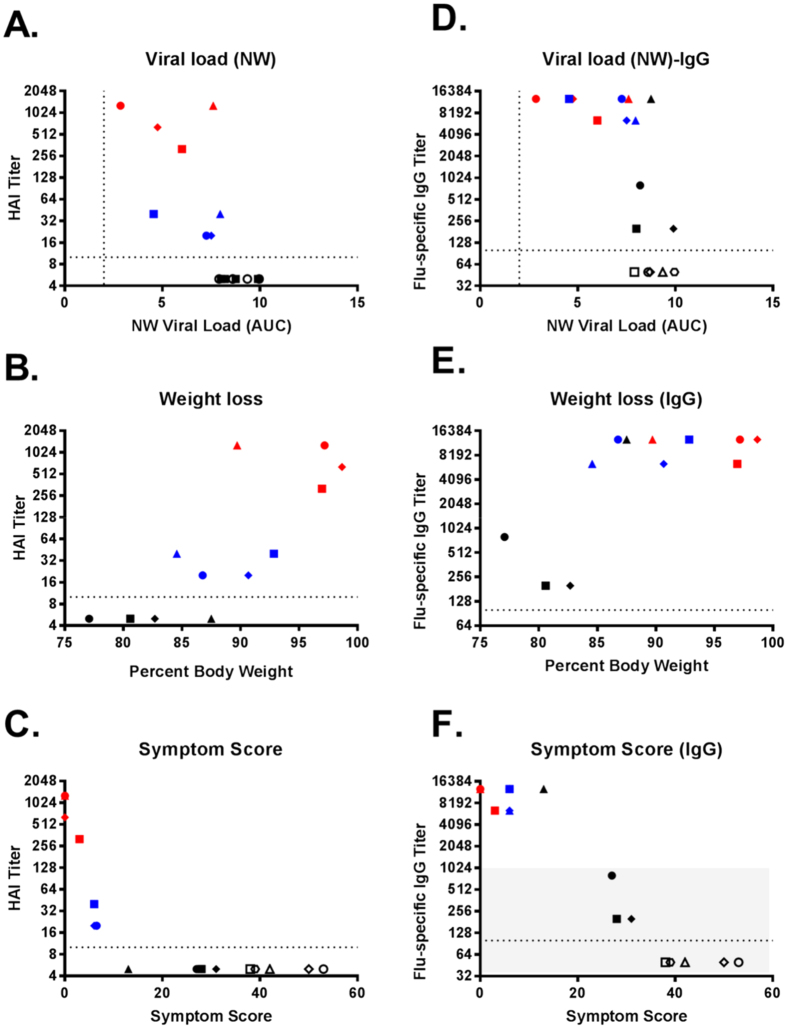
Relationship between pre-challenge HAI or IgG titers and measured clinical parameters after infection. Relationship between pre-challenge HAI or vaccine-specific IgG antibodies with (A,D) cumulative viral load in the nasal washes (NW), (B,E) weight loss and (C,F) cumulative symptom score. The total viral load were derived from Area-Under-the Curve (AUC) calculations in Fig. 2D. Cumulative symptom scores were tabulated in Table S1 over the 7 study-days. Ferrets that were euthanized were allocated the maximum score of 13 on days indicated with an E in Table S1. The area shaded in gray in (F) indicates ferrets that were euthanized. Individual ferrets are assigned its respective symbol within its vaccine group (colored as ○ for naïve, ● for unadjuvanted, for MF59 and for AS03).